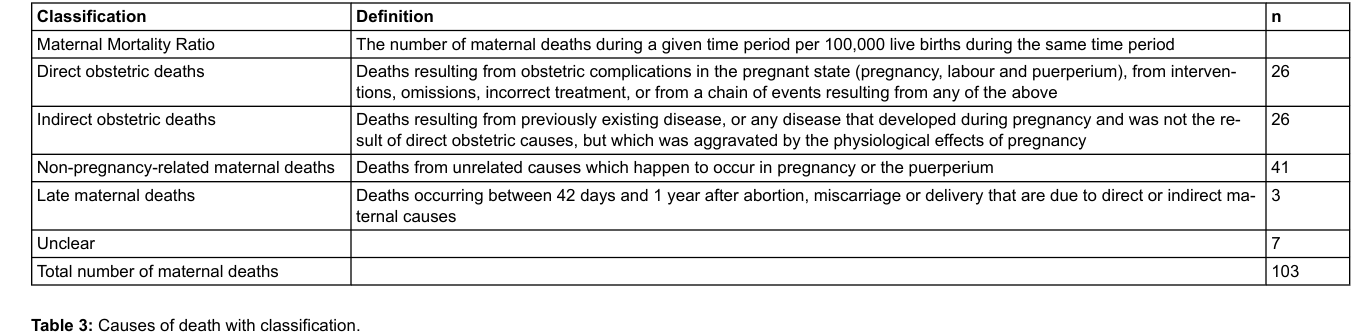
Table 2: Classification of maternal deaths (ICD-10) and maternal mortality ratio.